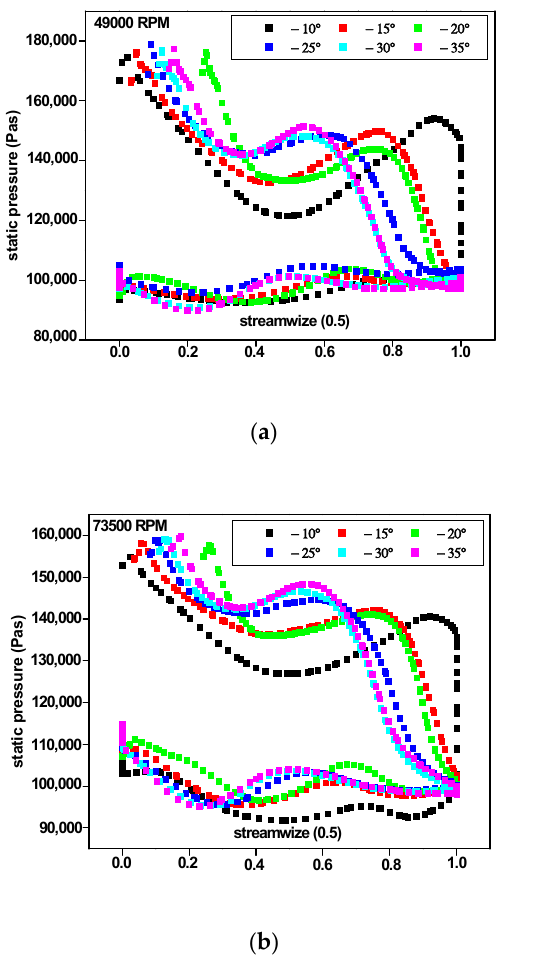
Figure 21. The pressure distributions around the blade profiles: ( a ) static pressure for different deviation blade angles in the mean radius at 50% rotation speed; ( b ) static pressure for different deviation blade angles in the mean radius at 75% rotation speed; ( c ) static pressure for different deviation blade angles in the mean radius at 100% rotation speed. From the total to static isentropic efficiency graph, it is clear that the efficiency is pro- portional with the increase of the deviation angle for the cases of a 75% and a 100% load but the case of a 50%, which decreased by increasing the deviation angle (Figure 22).